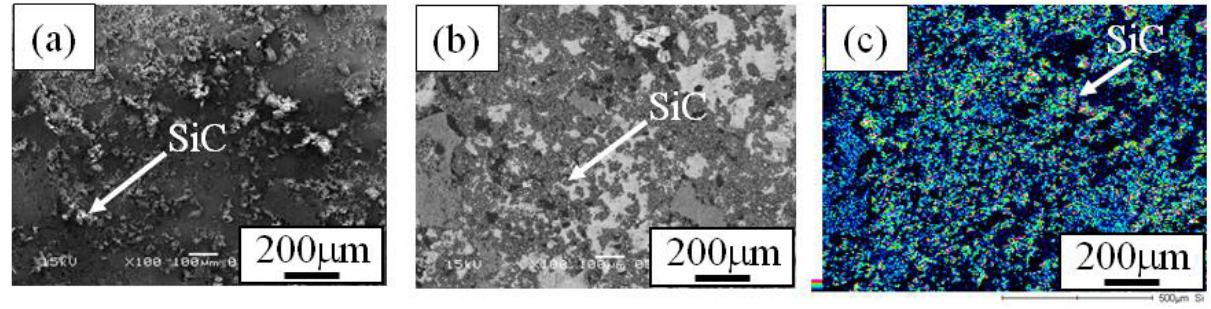
Figure 6. Microstructures on the surface of Specimens 3. (a) SE Image, (b) Compo Image and (c) Si distribution map by EDX